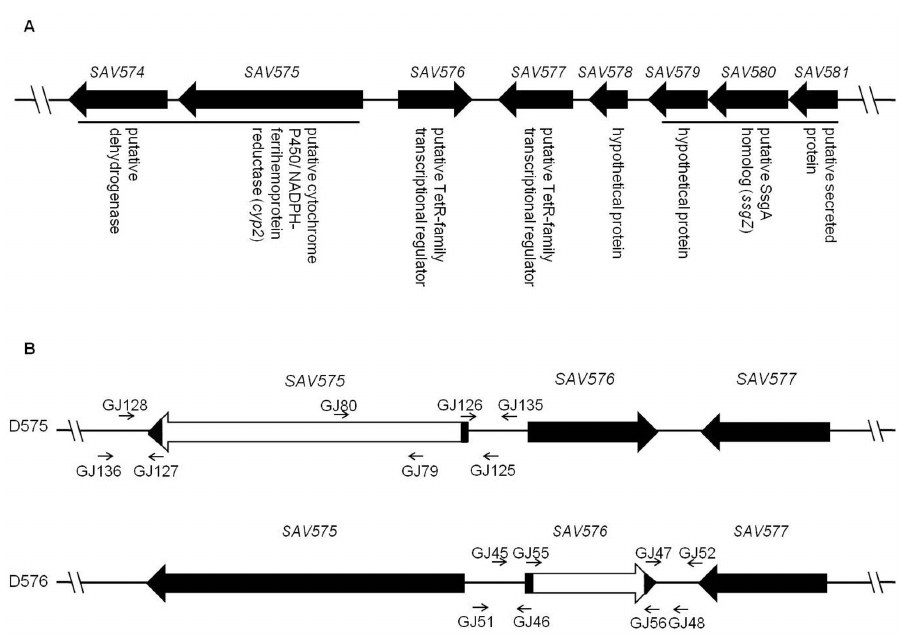
Figure 1. Organization of SAV576 and its adjacent genes on the chromosome of S.avermitilis (A) and schematic representation of the strategy used for deletion of SAV575 and SAV576 genes (B). ( ) Gene notations are based on the Genome Project of S. avermitilis (http:// avermitilis.ls.kitasato-u.ac.jp/). The two transcriptional units are indicated by black bars. ( B ) Long black arrows indicate genes and their directions. Short arrows indicate the positions of primers used for cloning exchange regions and confirming gene deletions. White blocks represent in-frame deletions in the corresponding genes.